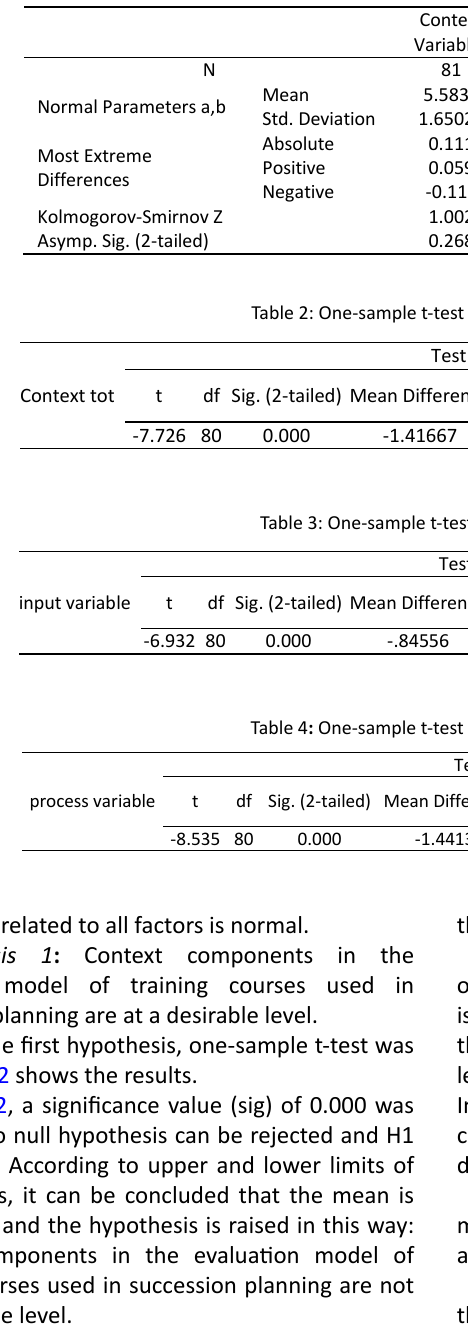
Table 1- Summary of Shapiro-Wilk and Kolmogorov-Smirnov tests for the studied components